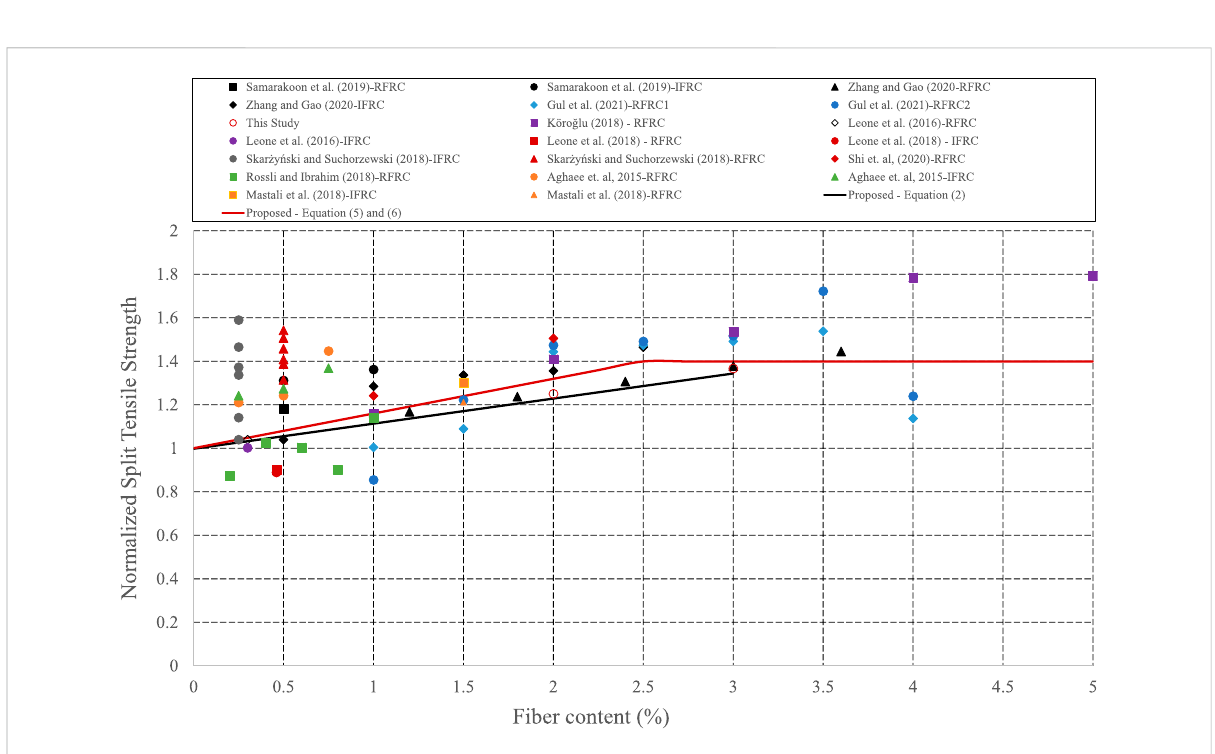
FIGURE 12 Variation of the splitting tensile strength of the steel fi ber reinforced concrete with the fi ber content.